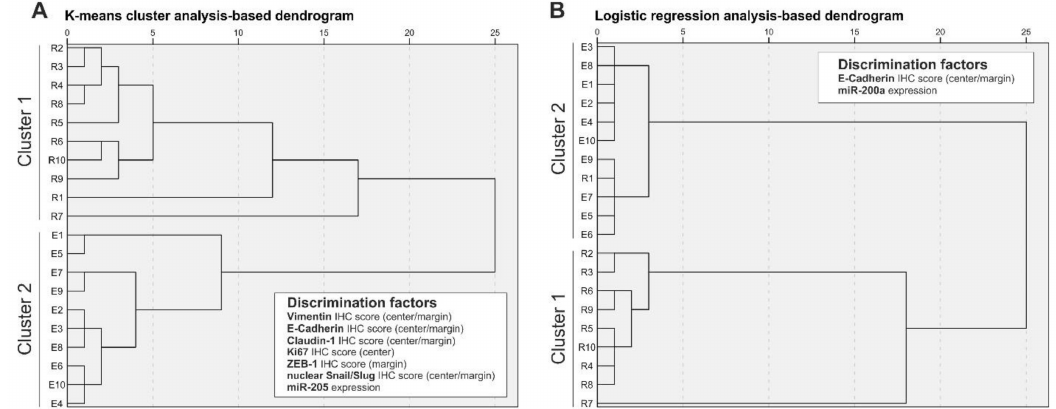
Figure 6. Determination of discrimination power using K-means cluster analysis ( A ) and logistic regression analysis ( B